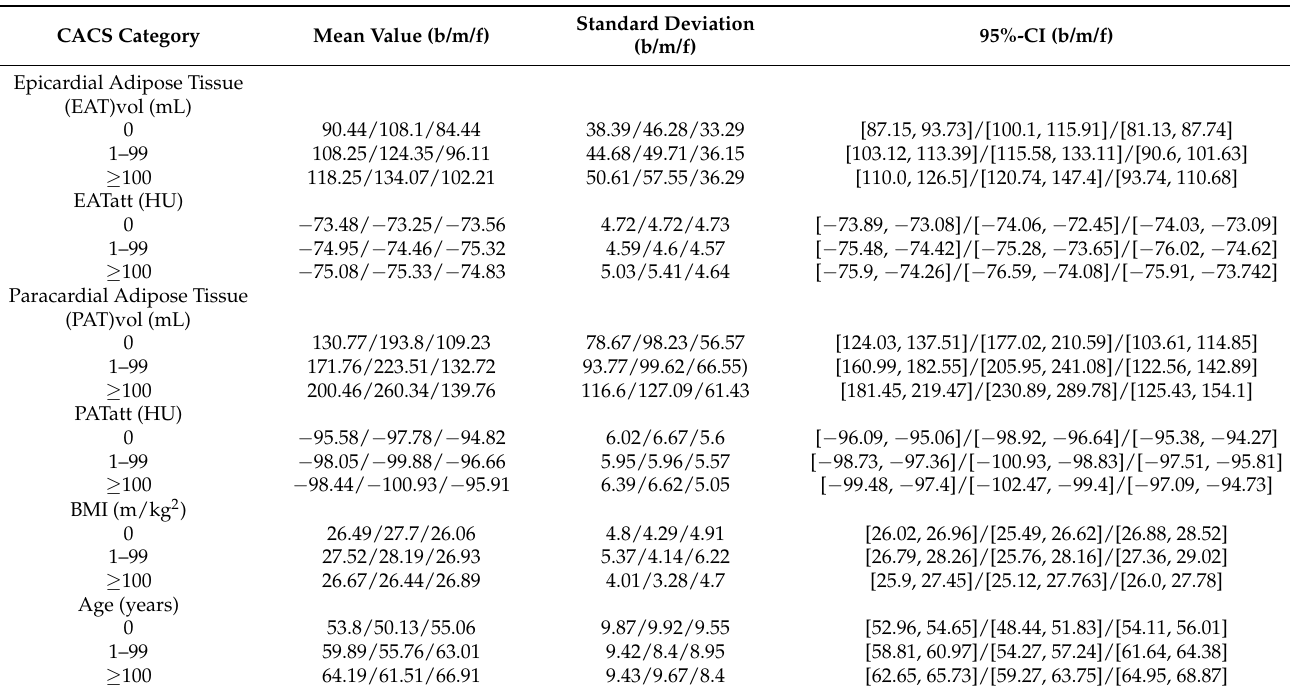
Table 2. Features measured and itemized into gender- and CACS groups (both/male/female) to allow for comparability to other study